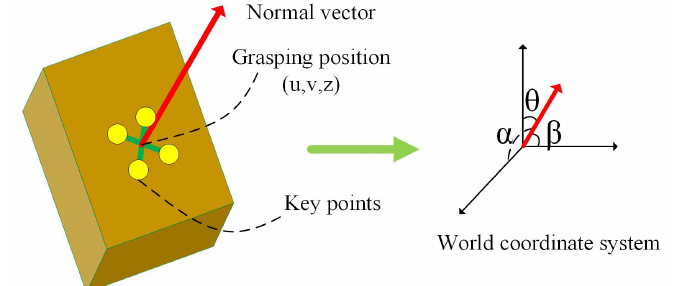
Figure 6. The model of the optimal sorting positions and poses for express